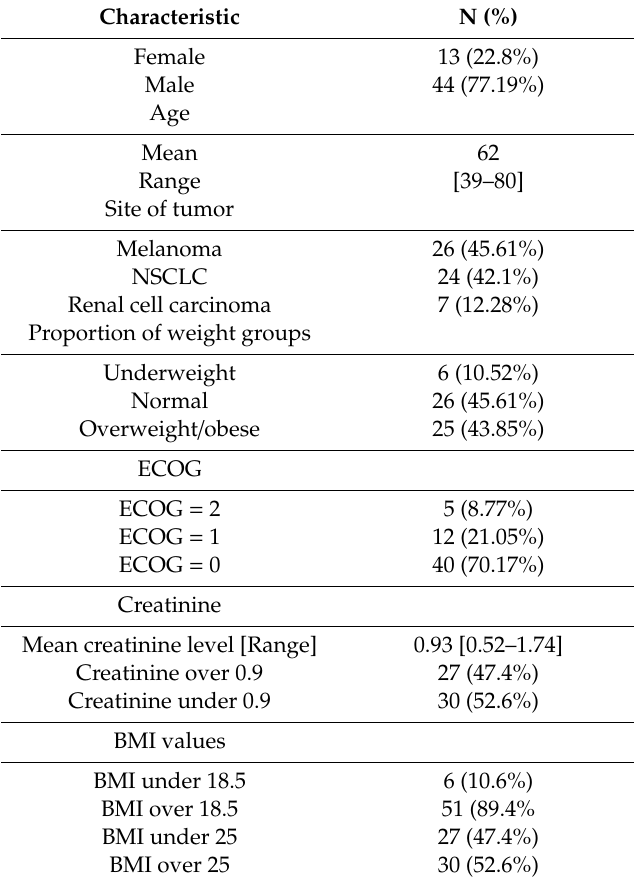
Table 1. Characteristics of the